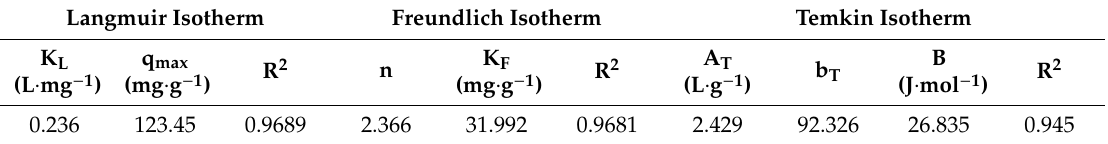
Table 3. Adsorption isotherms parameters for DCF adsorption on Fe@BC.